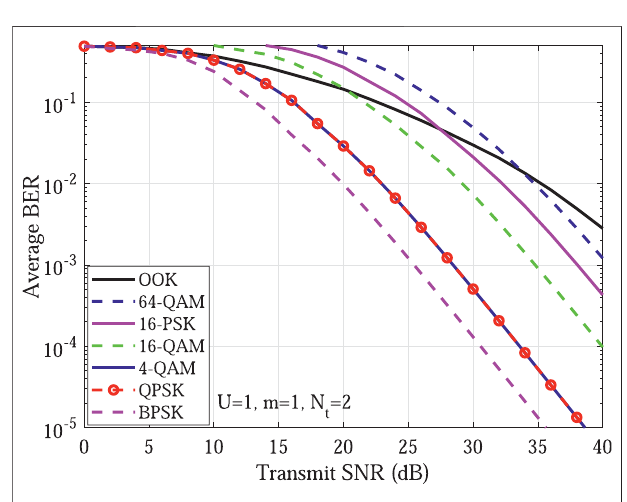
FIGURE 6 | ABER comparison for various modulation